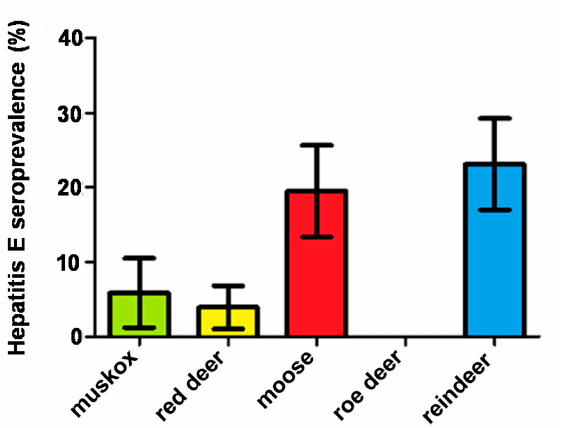
Figure 2. Seroprevalence values for the tested muskoxen ( Ovibos moschatus ), red deer ( Cervus elaphus ), moose ( Alces alces ), roe deer ( Capreolus capreolus ), and European Eurasian tundra reindeer ( Rangifer tarandus ) evaluated in the study. The 95% confidence interval is represented in the T-shaped bars.